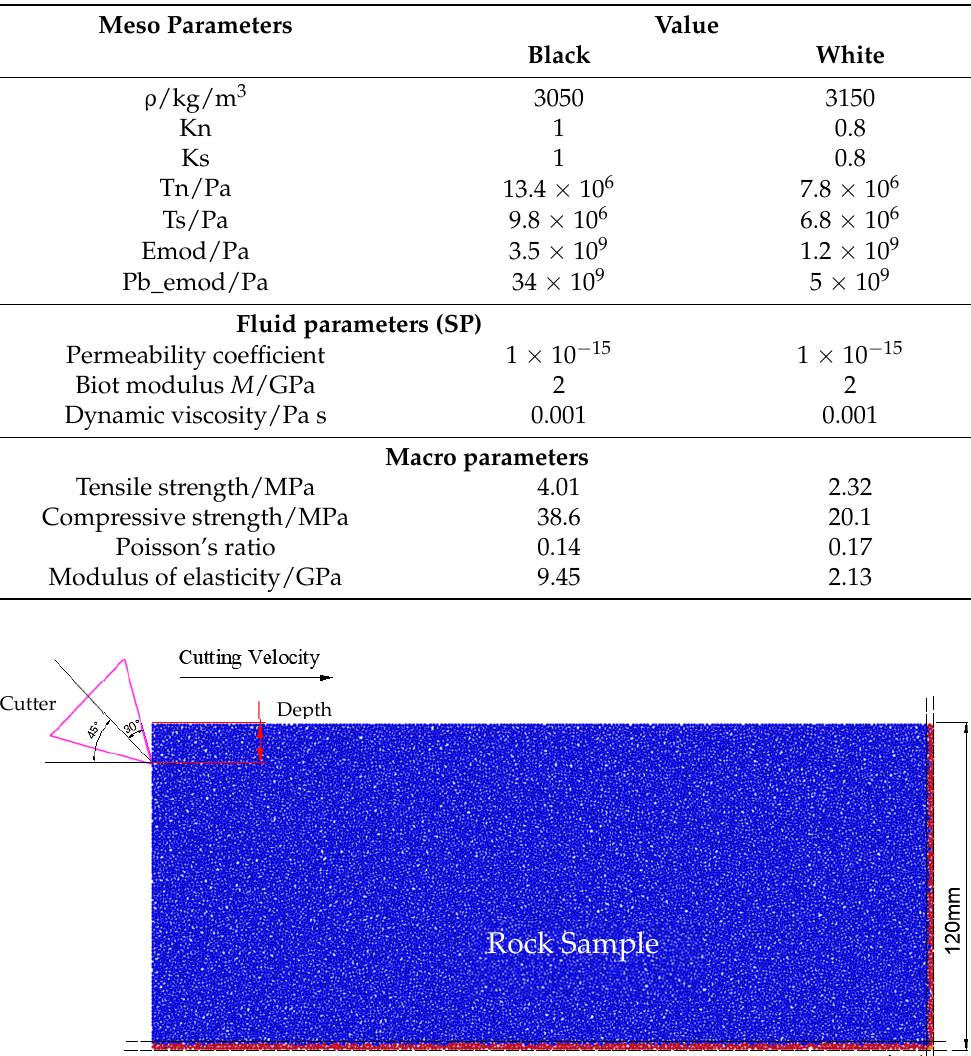
Table 3. Solid parameters of SMS sample.